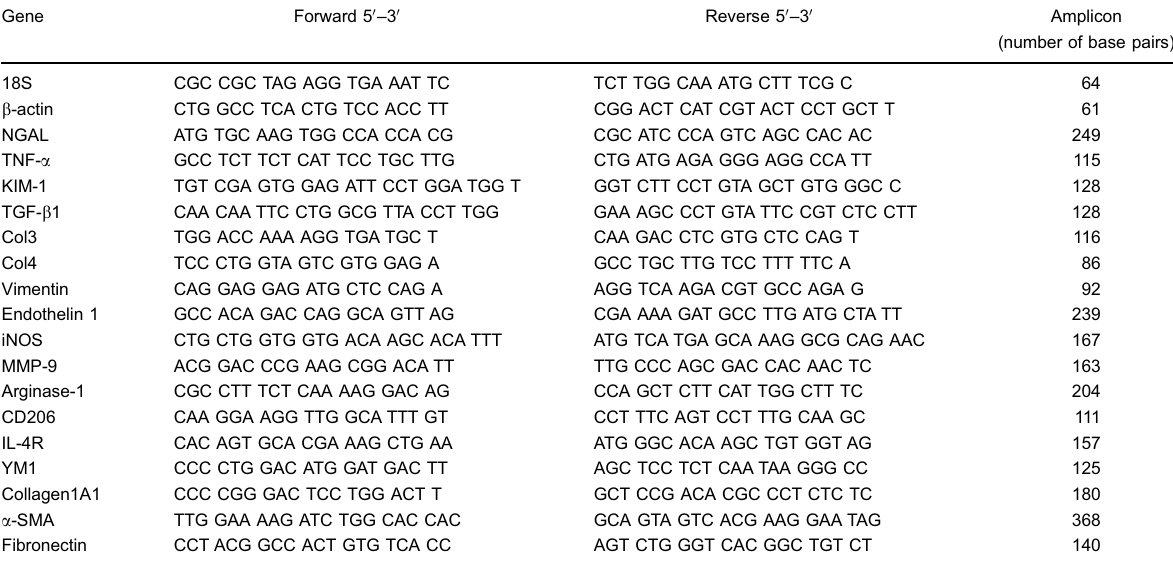
Table 1. Sequences of the primers used for real-time PCR assays.